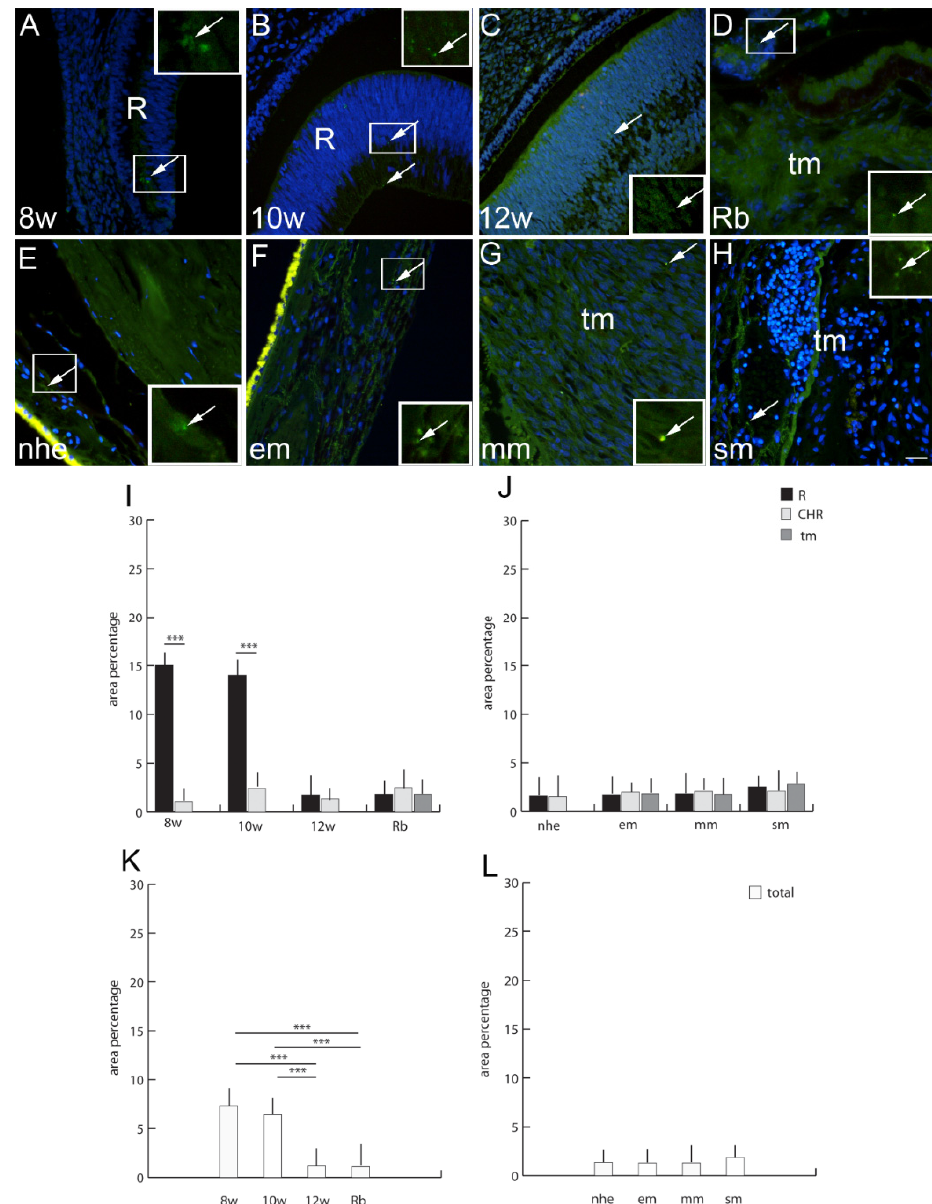
Figure 5. Connexin 45 (Cx45)-positive cells (arrows) can be seen in the eye section of an 8th-week (8 w) ( A ), 10th-week (10 w) ( B ) and 12th-week (12 w) ( C ) human embryo, retinoblastoma (Rb) ( D ), normal human eye (nhe) ( E ), epitheloid melanoma (em) ( F ), mixoid melanoma (mm) ( G ) and spindle melanoma (sm) ( H ); R—retina, tm—tumor tissue. Immunofluorescence staining to Cx45 (green) merged to DAPI (blue nuclei), scale bar 25 µ m. The panel with graphs represents the area percentages of Cx45 in the retina (R), choroid (CHR) and tumor (tm) in the 8th-week (8 w), 10th-week (10w) and 12th-week (12w) human embryo, retinoblastoma (Rb), normal human eye (nhe), epitheloid melanoma (em), mixoid melanoma (mm) and spindle melanoma (sm) ( I , J ), and total area percentage of Cx45 ( K , L ). Data are shown as mean ± SD. Significant differences are indicated by *** p < 0.001. One-way ANOVA followed by Tukey’s multiple-comparisons test (comparison between Rb and uveal melanoma types), t -test (comparison between retina and choroid of developmental stages and normal human eye).